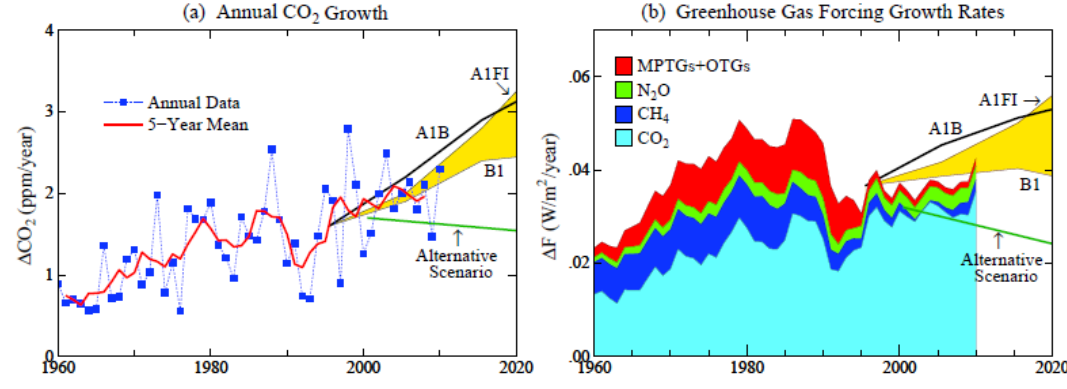
Fig. 16. Annual growth of (a) atmospheric CO 2 and (b) climate forcing by long-lived greenhouse gases (GHGs). The GHG forcing is the 5-yr running mean, except the final two points, for 2009 and 2010, are 3-yr and 1-yr means. For explanations see Hansen and Sato (2004).